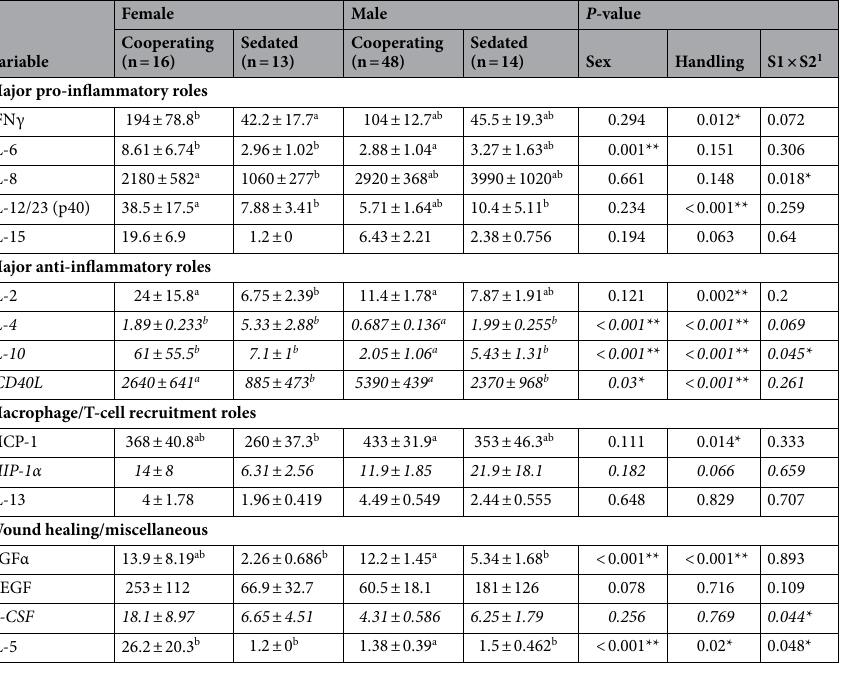
Table 3. Multivariate analysis of the impact of sex and handling variables on cytokine expression demonstrated that among cooperating cynomolgus macaques, males and females demonstrated a significantly different cytokine expression profile. The effect of handling had a greater impact on cytokine expression (significant for nine cytokines), than the impact of sex (significant for six cytokines). The interaction between sex and subject handling was significant for four cytokines. Descriptive statistics are presented as cytokine concentration (pg/mL). Two-way ANOVA was performed using Box-Cox transformed data to meet statistical assumptions. Regular text = accept; italicized = marginal. Cytokines with validation outcome of reject are not included. Values are means ± SEM. *p < 0.05; **p < 0.01; ***p < 0.001; ****p < 0.0001. a,b Means that are not significantly different as reported by an all-pairwise comparison are followed by a common superscript letter. Groups were analyzed by two-way ANOVA and the Tukey test. 1 S1 × S2 = Sex × Handling interaction